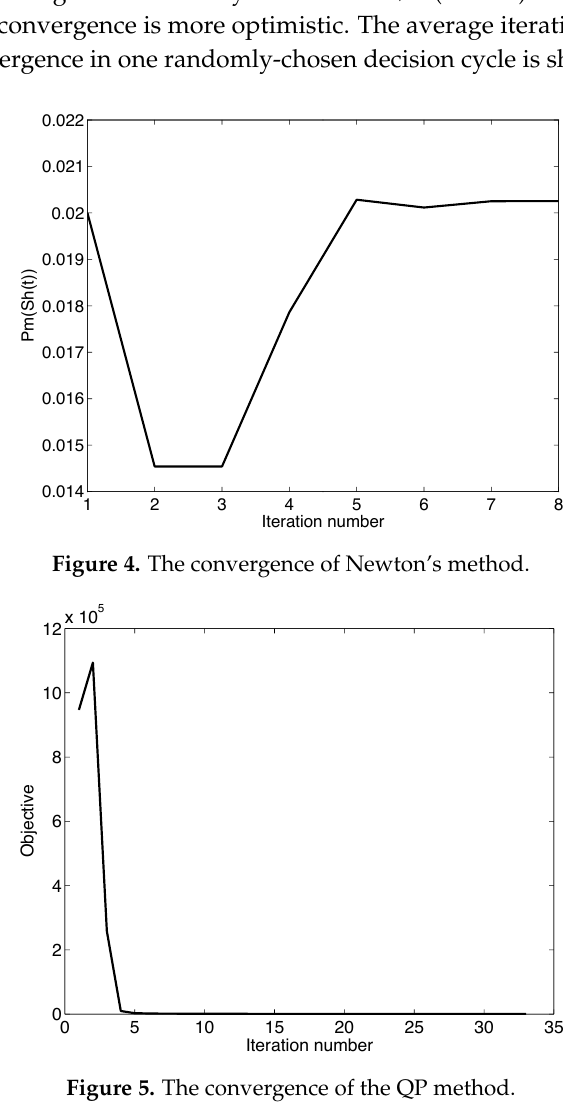
Figure 5. The convergence of the QP